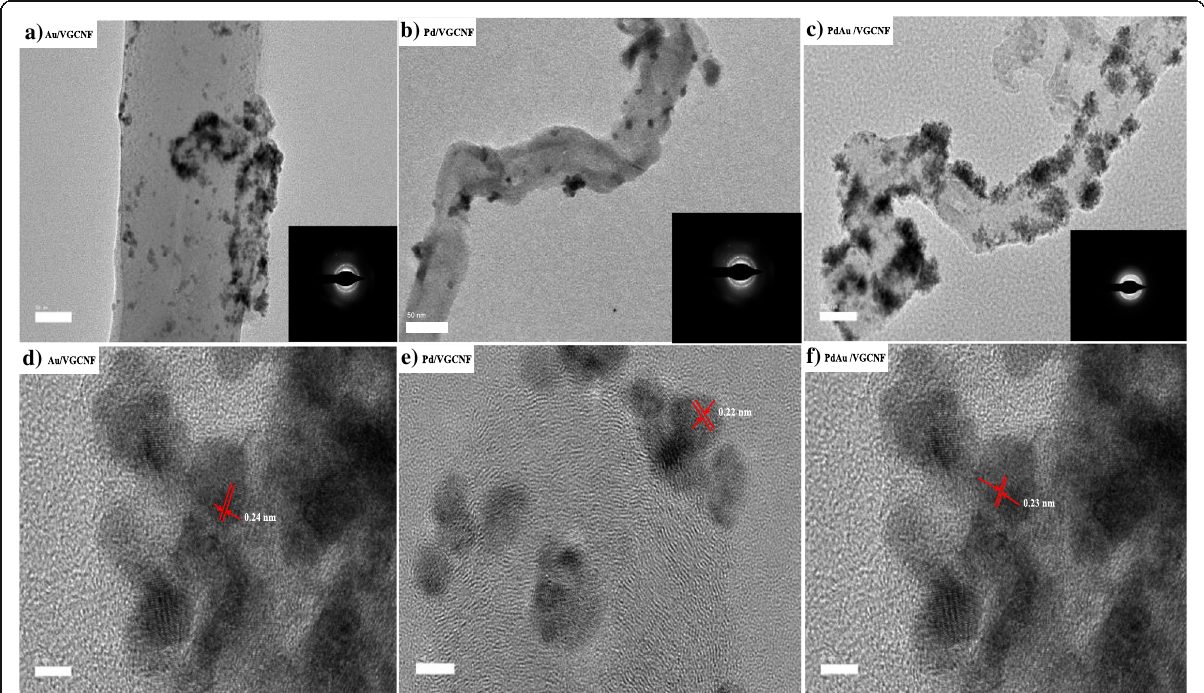
Fig. 2 a – c Typical images of TEM and SAED pattern for Au/VGCNF, Pd/VGCNF, and Pd 1 Au 1 /VGCNF. d – f HRTEM images for Au/VGCNF, Pd/VGCNF, and Pd